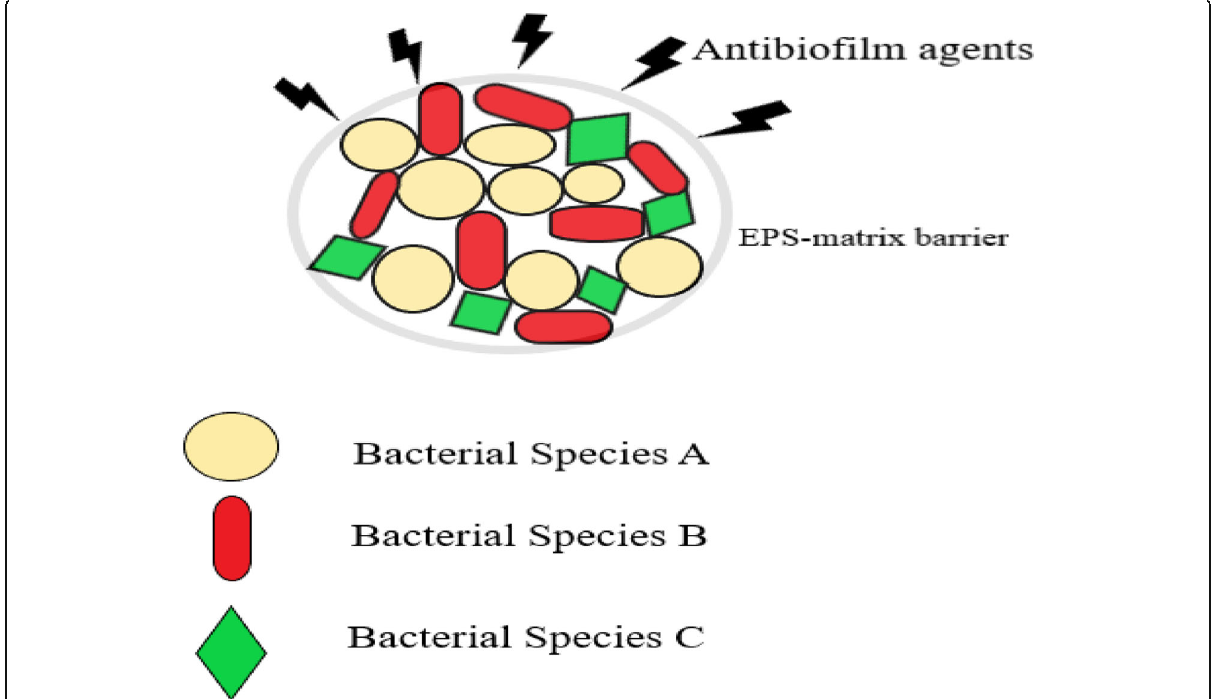
Fig. 5 Representation of multiple bacterial species residing within the same